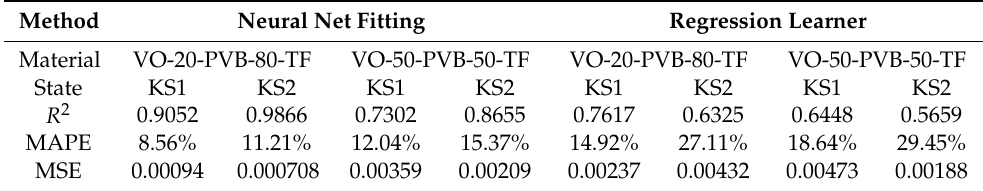
Table 1. Comparison of proposed models [authors’ own